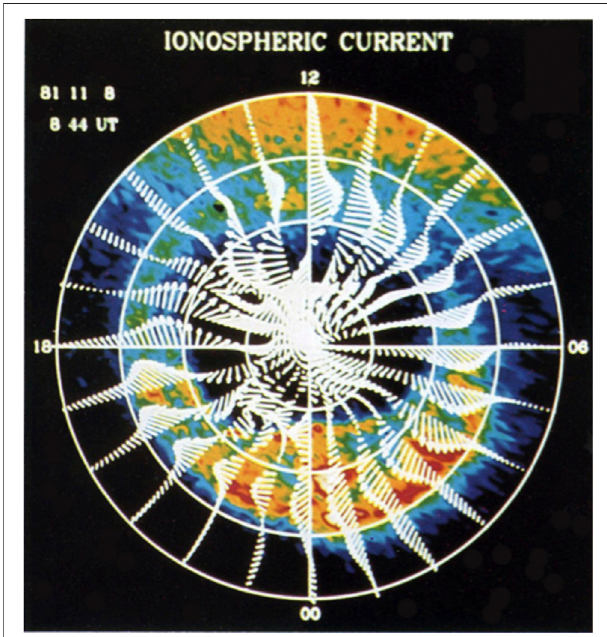
FIGURE20| Anexampleofsimultaneousobservation oftheaurorabya satellite and the distribution of electric currents obtained by the six meridian chains of magnetometers ( Electric Current Approach ), Craven et al.